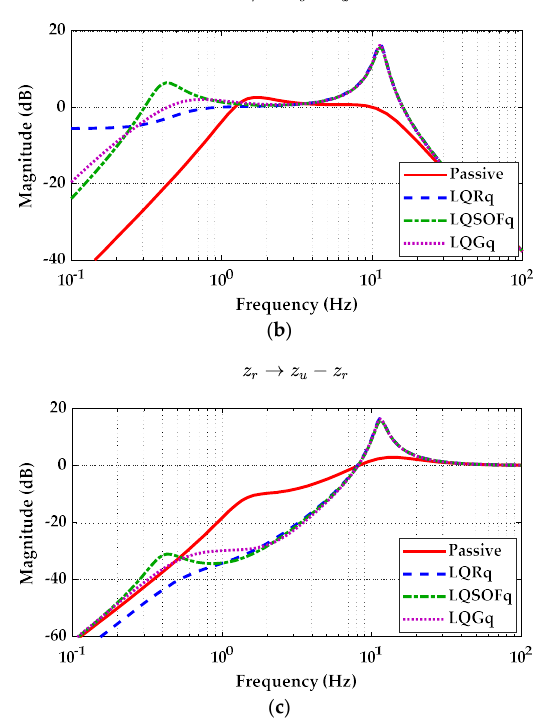
Figure 7. Frequency responses from the road profile z r to each output for the quarter-car model. ( a ) Vertical acceleration of the sprung mass; ( b ) Suspension stroke; ( c ) Tire deflection.